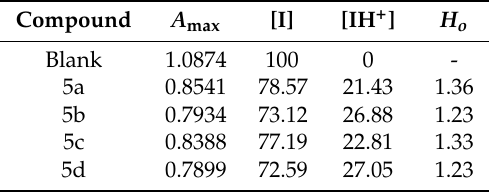
Table 5. Summary of Brønsted acidity of B-L MILs ( A max : the maximum absorption, [I]: the concentration of indicator, [IH + ]: the concentration of protonated indicator, H o : Brønsted acidity). Compound